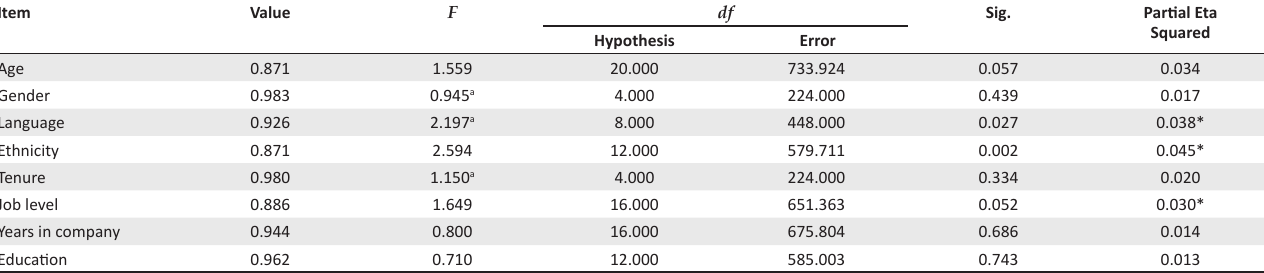
TABLE 5: Manova for barriers to change and the demographic variables. Item